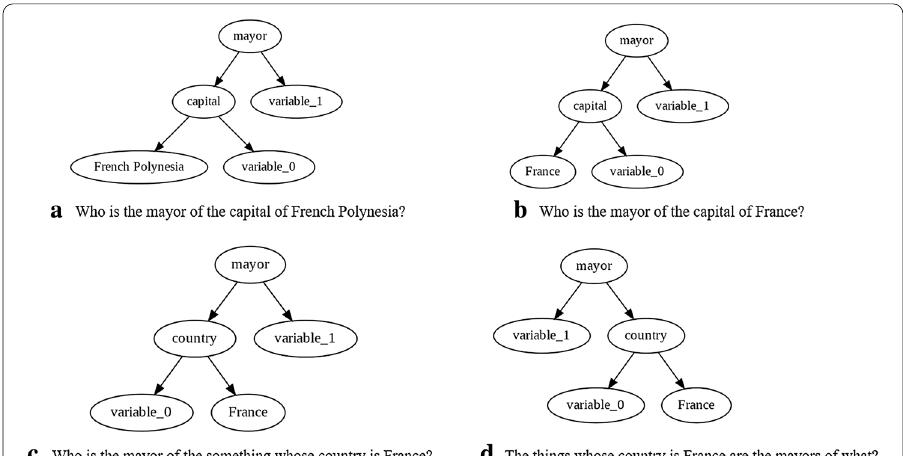
Fig. 4 Tree representation of four possible queries of the example question: “Who is the mayor of the capital of French Polynesia?” along with their semantic